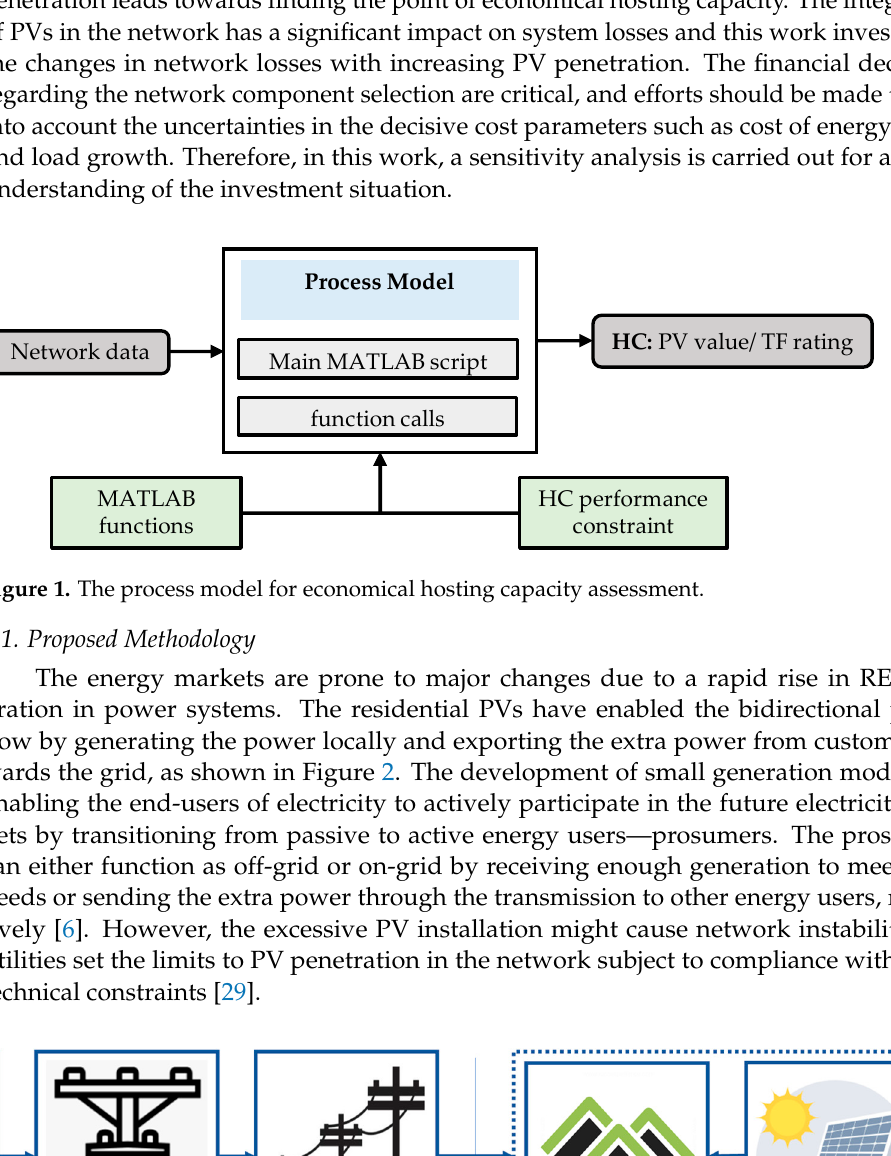
Figure 2. An illustration of distributed generation at consumer (prosumer) premises in future power system.